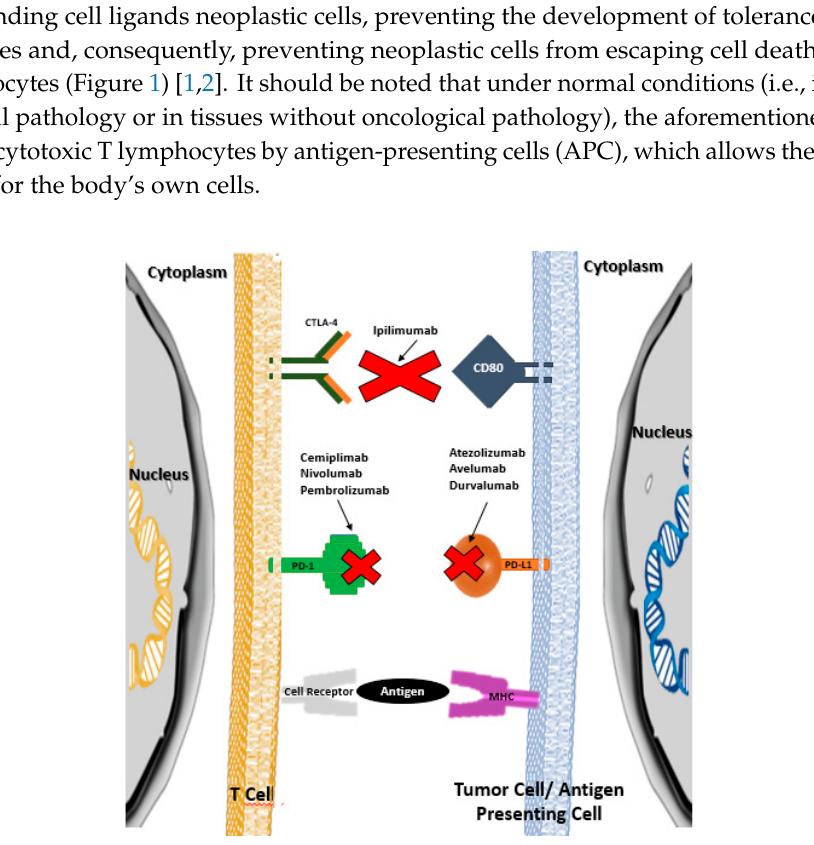
Figure 1. Therapeutic targets of immunological checkpoint inhibitors (adapted from references [1] and [2] ).